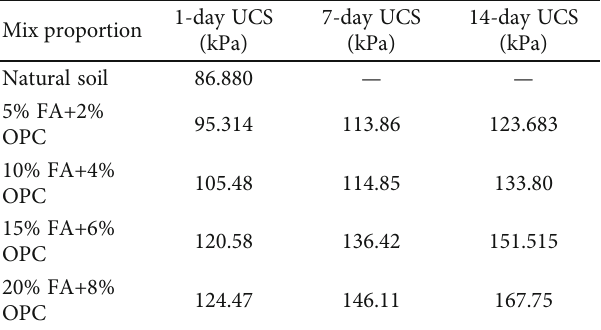
Figure 6: California bearing ratio of fl y ash and cement mixture. Table 6: The e ff ect of adding cement and fl y ash on the UCS